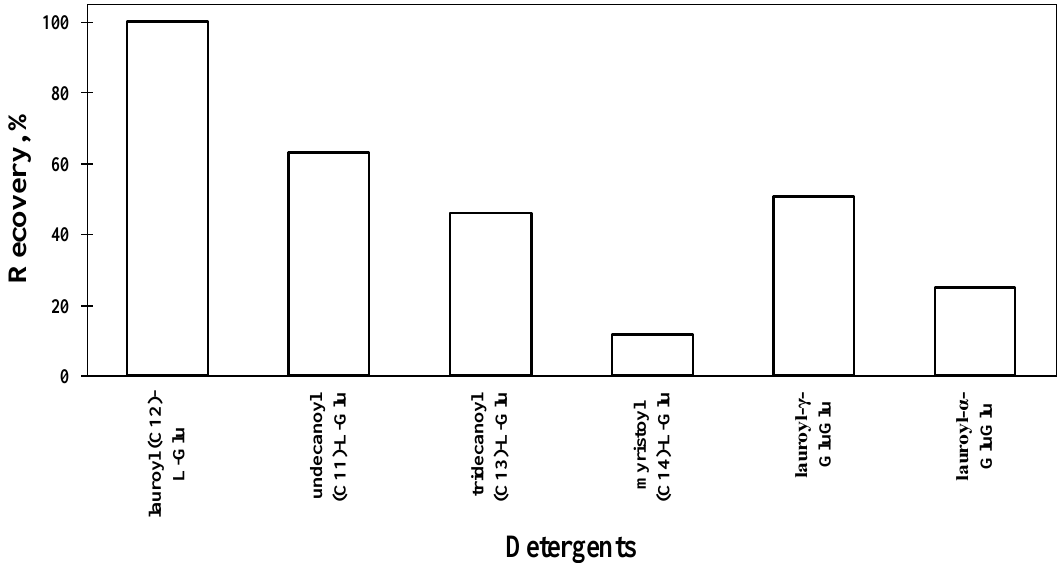
Figure 4. Refolding of IL-6 by glutamate-based detergents.